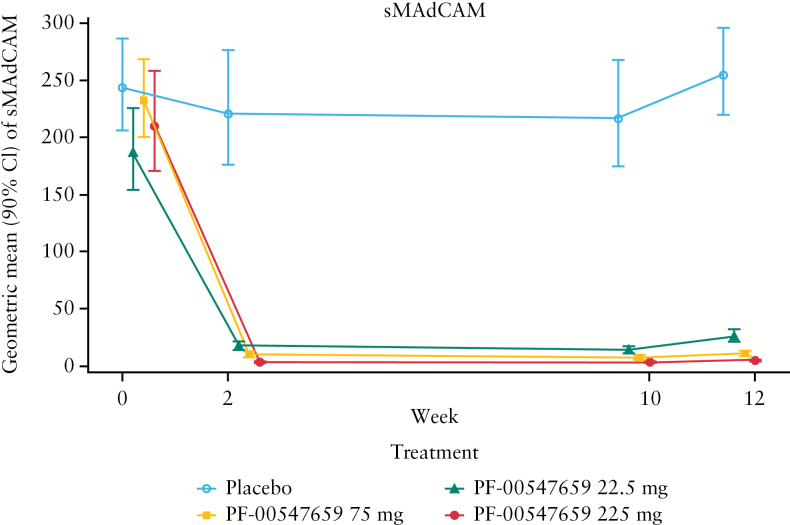
The time course of serum soluble MAdCAM levels [geometric mean 90% CI, ng/ml] in patients following treatment with placebo or PF-00547659. Different symbols represent different dose groups: ○ placebo, ▲ PF-00547659 22.5 mg, ■ PF-00547659 75 mg, and ● PF-00547659 225 mg. CI, confidence interval; sMAdCAM, soluble mucosal addressin cell adhesion molecule.